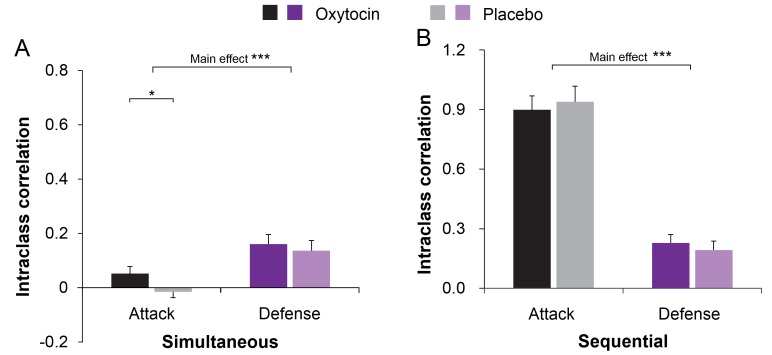
Oxytocin increases attacker group’s within-group coordination especially in the simultaneous decision-making block. Connectors indicate significant difference, with *p<0.05, *** p< 0.001.